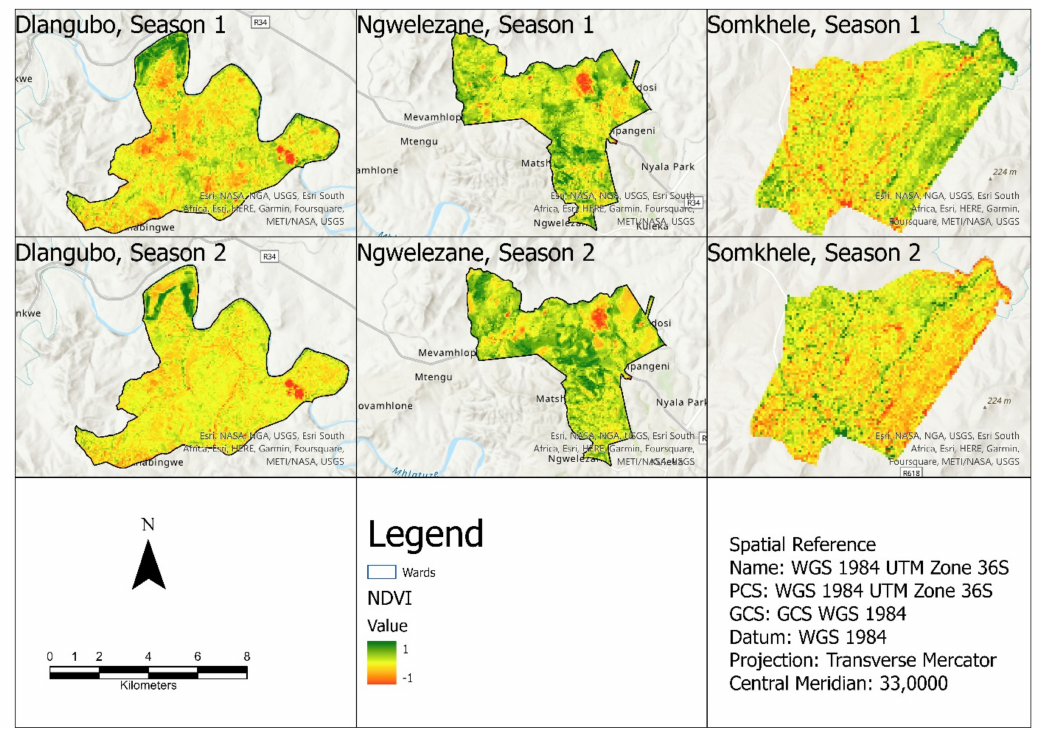
Figure 1. The NDVI of the Dlangubo, Ngwelezane, and Mtubatuba sites in season one and the season two of 2019 and 2021 as determined by satellite imagery. The variation in the greenness of the sites was an indication of the variation in the health of the vegetation in the sites. The greenness of the sites varied thus: Ngwelezane > Dlangubo > Somkhele. Generally, season two is less green than season one. The sites were in ward 24 (Dlangubo), ward 29 (Ngwelezane), and ward 14 (Somkhele) of the KwaZulu-Natal province of South Africa. Note: This figure is our original work. The use of it in part or whole is allowed, but the authors must be referenced appropriately.